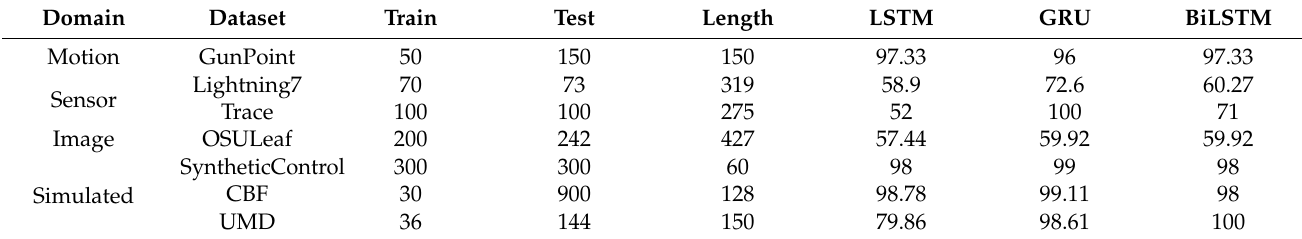
Table 2. The classification accuracy of different datasets using RNN series network.